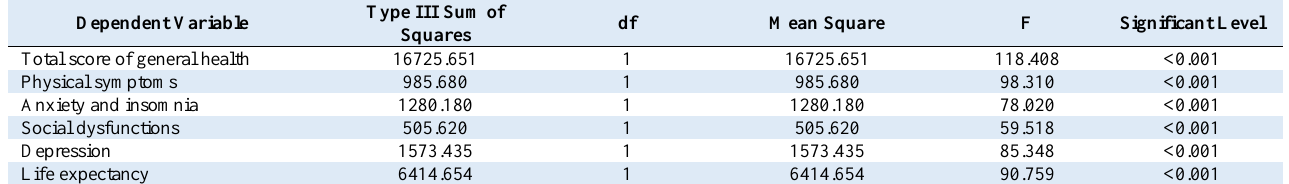
Table 4. The results of ANOVA in the MANOVA text on the mean score of life expectancy, total score of general health and its subscales in students with favorable and unfavorable socio-economic status Dependent